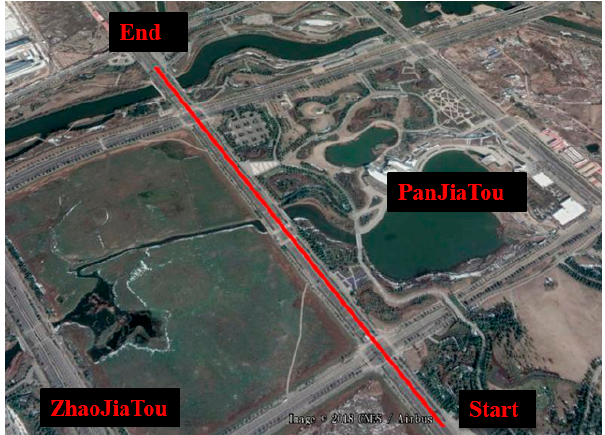
Figure 7. Field testing trajectory.